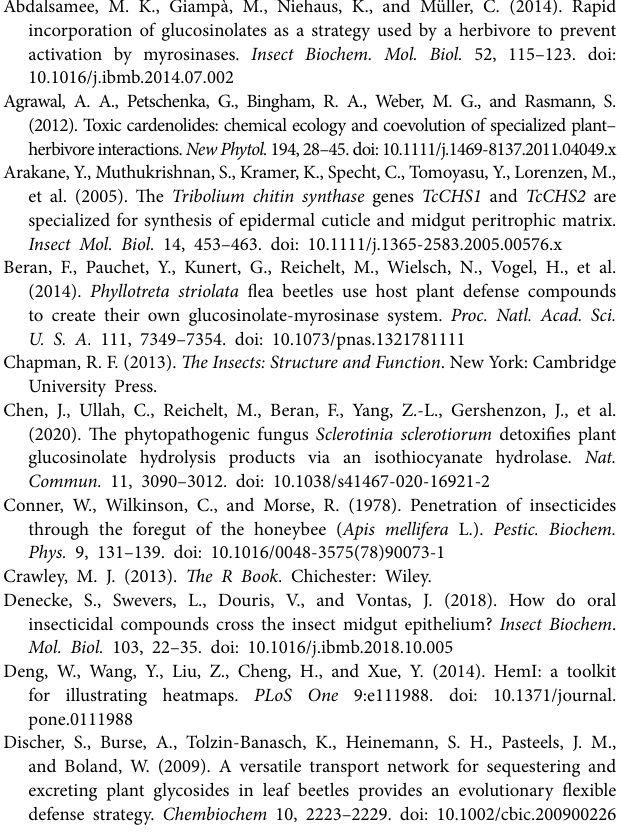
Supplementary Table 3 | Methods and results of statistical